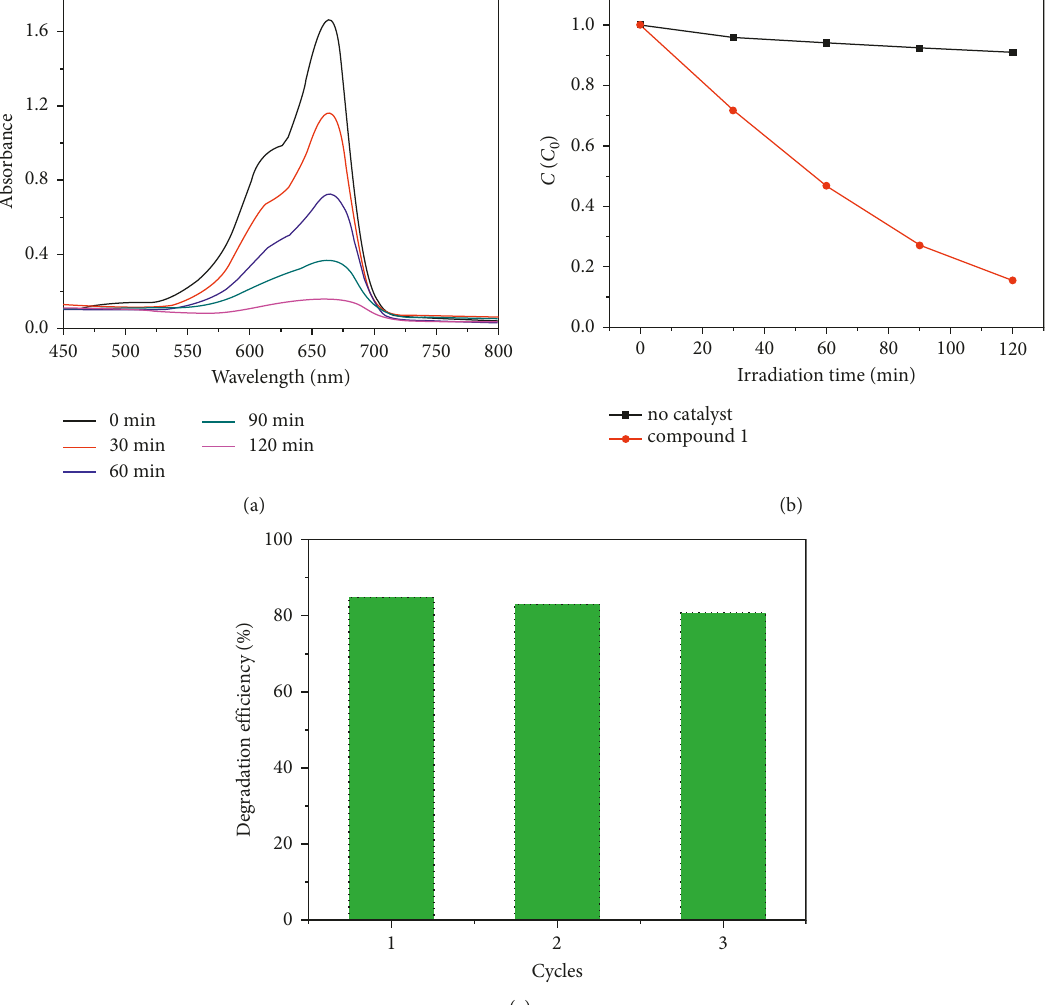
Figure 4: (a) The ultraviolet-visible absorption spectra of the MB solution in the course of photodegradation using compound 1 as a photocatalyst. (b) The plots of C / C 0 versus irradiation time with and without 1 as photocatalyst. (c) Three cycling runs with the recovered photocatalyst in the degradation of MB.